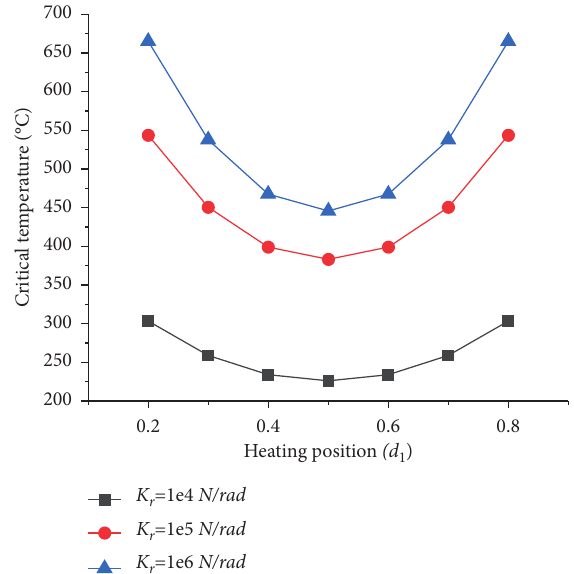
Figure 6: Critical temperatures of composite laminated plates with different heating positions.